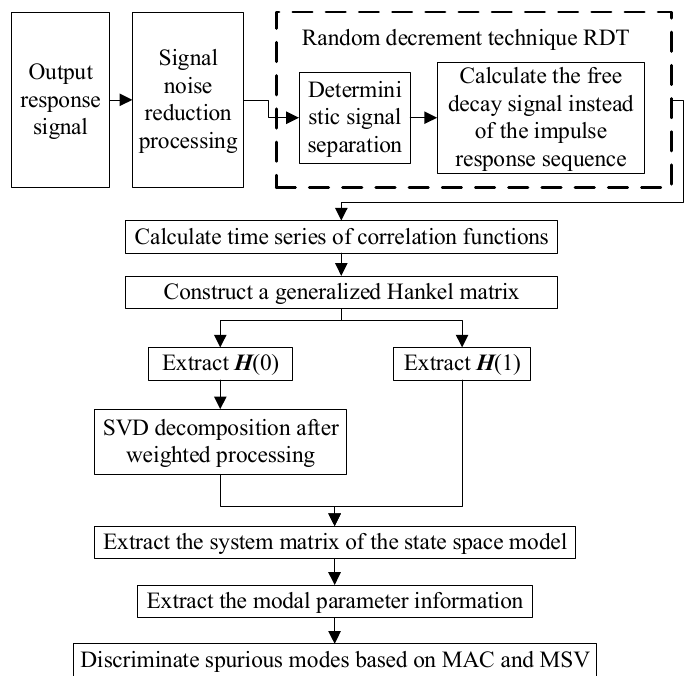
Figure 9. Flow chart of modal recognition fusion algorithm.